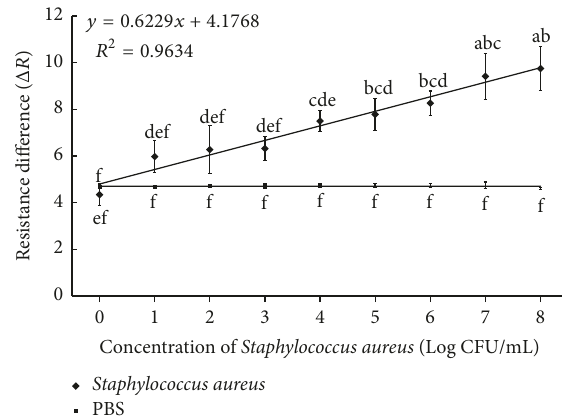
Figure 6: Resistance difference of SWCNT-based biosensor reacted with the selected concentration of Staphylococcus aureus from 10 0 to 10 8 CFU/mL. Error bars represent standard deviation ( 𝑛 = 3 ). Different superscript letters (a–f) represent significant differences among the samples at 𝑃 < 0.05